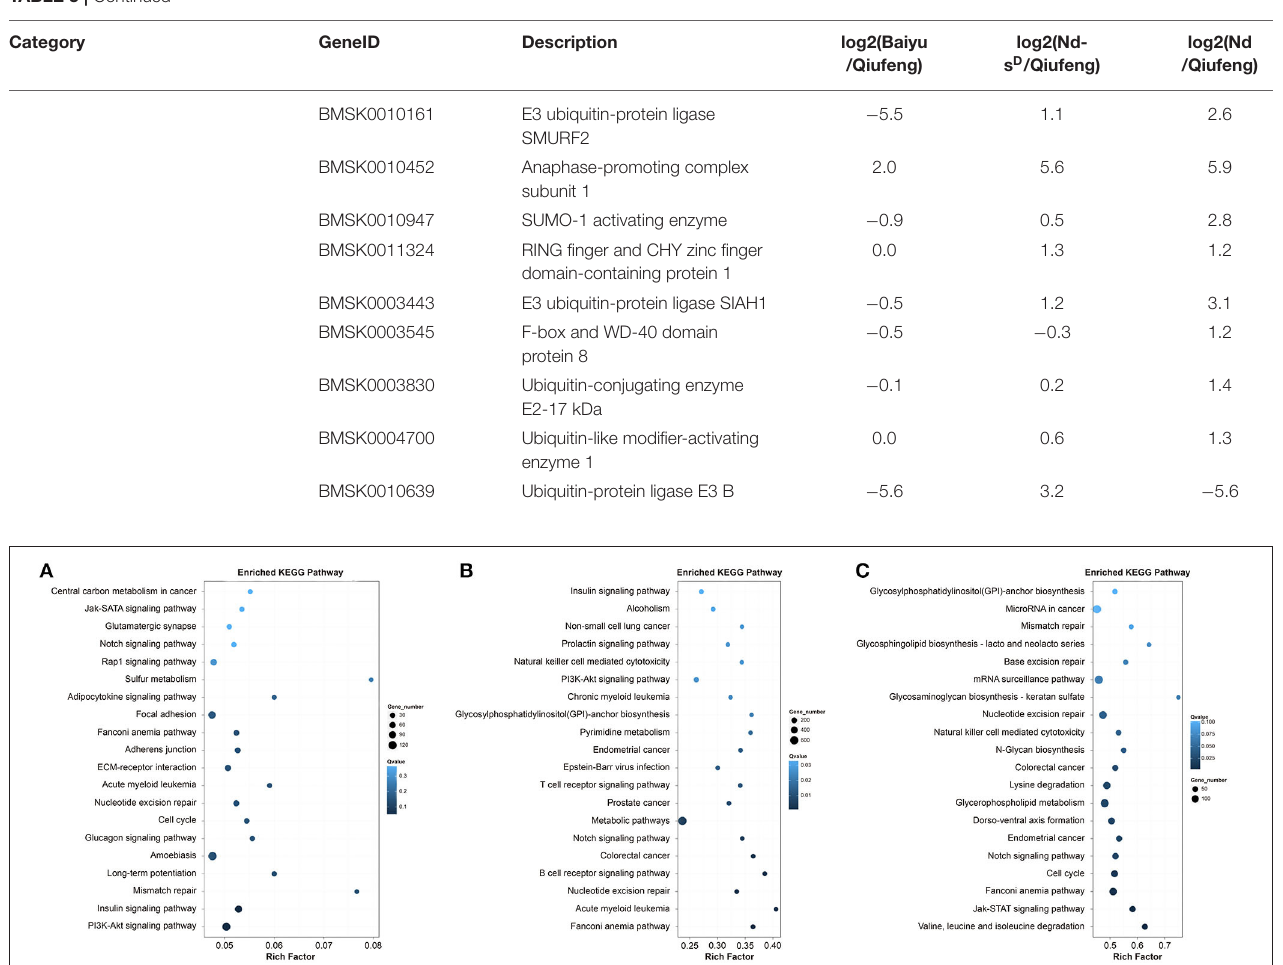
FIGURE 5 | Top 20 KEGG pathways of the DEGs in Qiufeng vs. Baiyu (A) , Qiufeng vs. Nd-s D (B) and Qiufeng vs. Nd (C) . “Rich factor” indicates the ratio of the number of DEGs enriched in the pathway to the total number of genes annotated in the